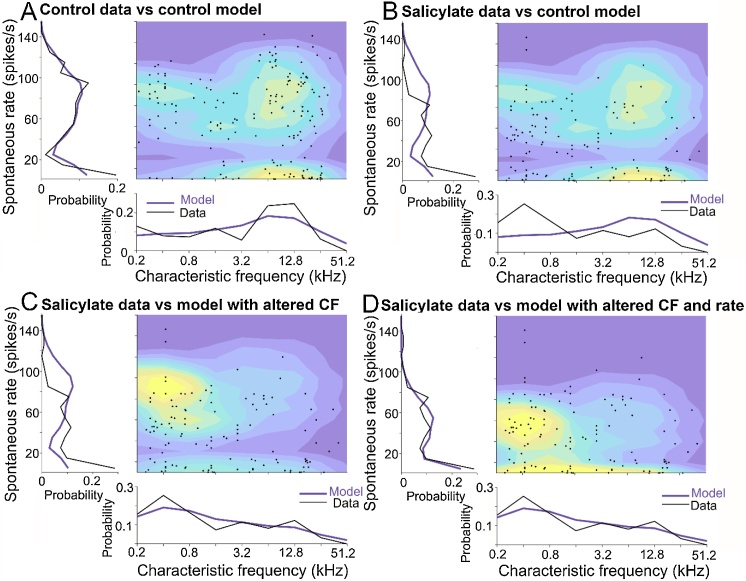
(A) Probabilistic model of spontaneous rate vs. CF for the control auditory nerve data shown as a contour map with warmer colours indicating a higher probability and the actual data superimposed as black dots. (B) Salicylate data (black dots) superimposed on the control contour map. (C) Contour map derived from the function for the control fibre rate probability and the salicylate CF sampling probability with the salicylate data superimposed. (D) A contour map based on the sampling CF function from the salicylate data and the spontaneous rate function from the control data after firing rate of all fibres has been reduced by 32 spikes/s unless this would make their value negative. This provided the value of best fit to the original salicylate data (black dots).